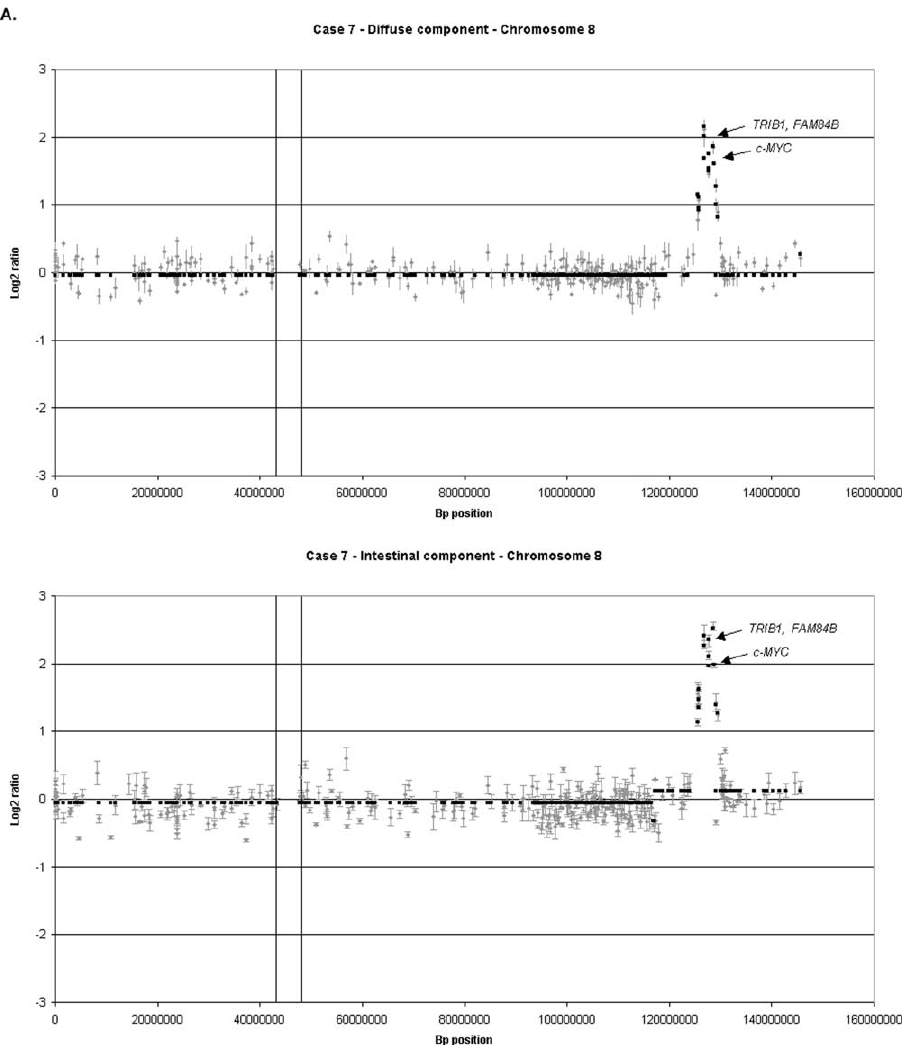
Fig. 2. Two cases with amplification of specific genomic regions. Case #7 present an amplification on chromosome 8q (A) and case #1 on chromosome 17q (B). Black squares-smoothed ratios. Two vertical lines – centromeric region.